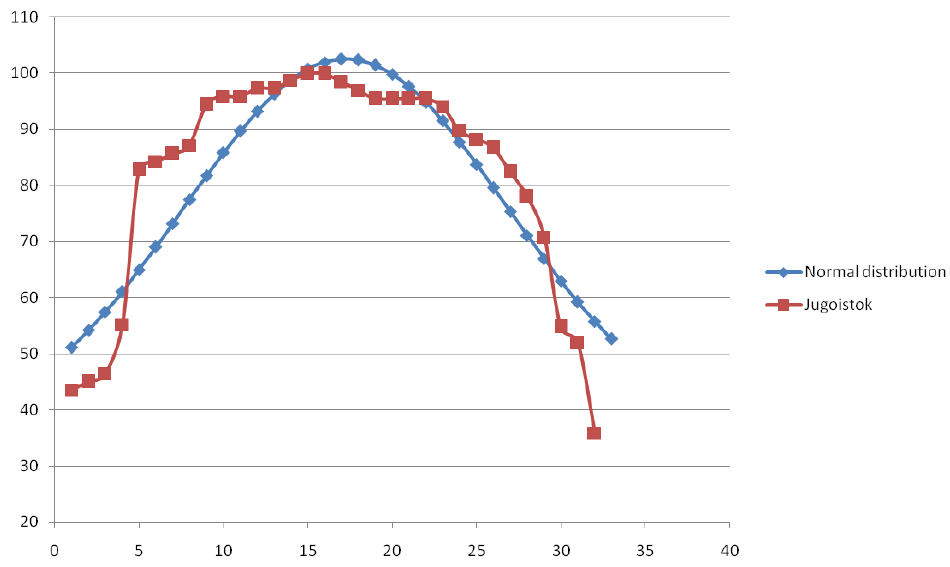
Figure 6. Normalized power load value distribution compared to the normal (or Gaussian) distribution for the given range of values—source: ED Jugoistok Niš.